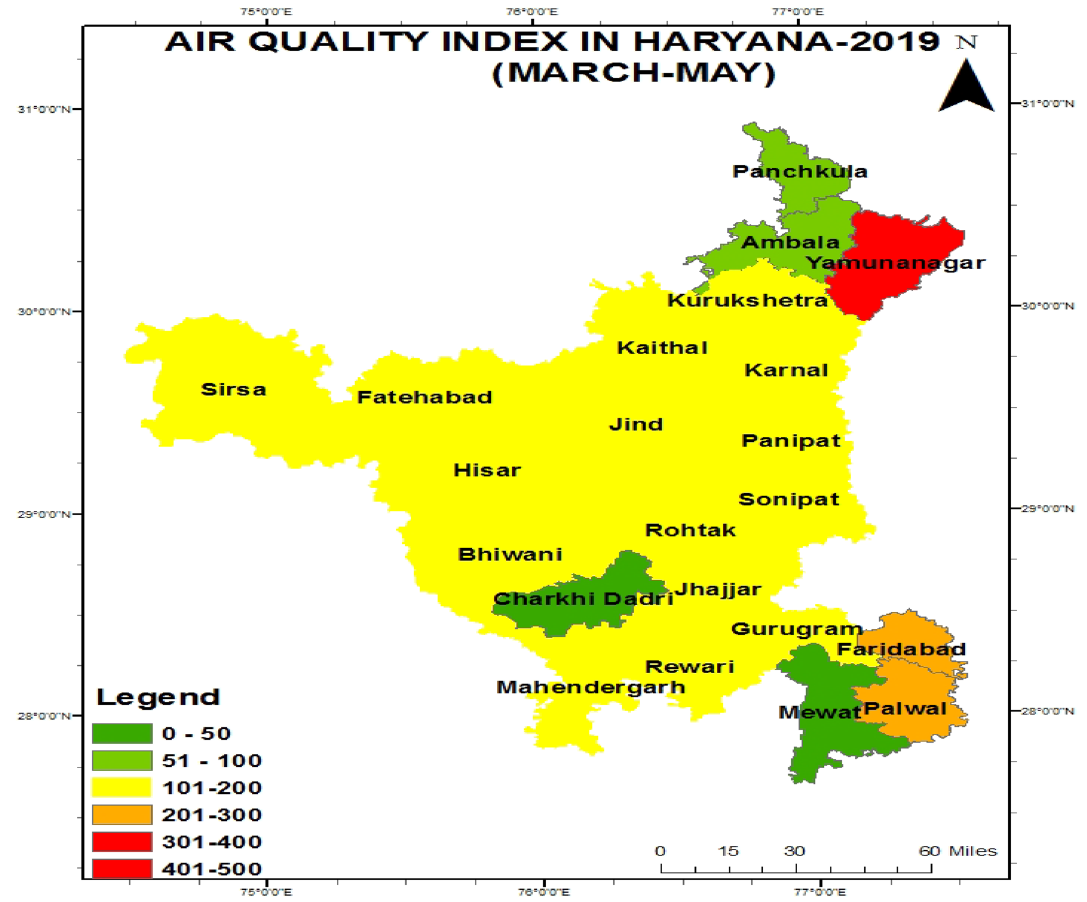
Figure 2. Figure showing the map of Haryana with their respective air quality index during